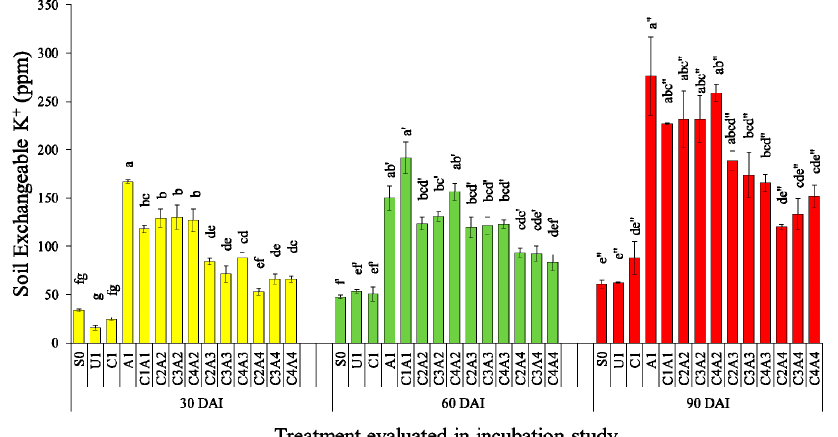
Figure 9. Treatments on soil exchangeable potassium ions after thirty, sixty, and ninety days of incubation. Means with different letter(s) within the same incubation period indicate significant difference between treatments by Tukey’s HSD test at p ≤ 0.05. Bars represent the mean values ± SE.